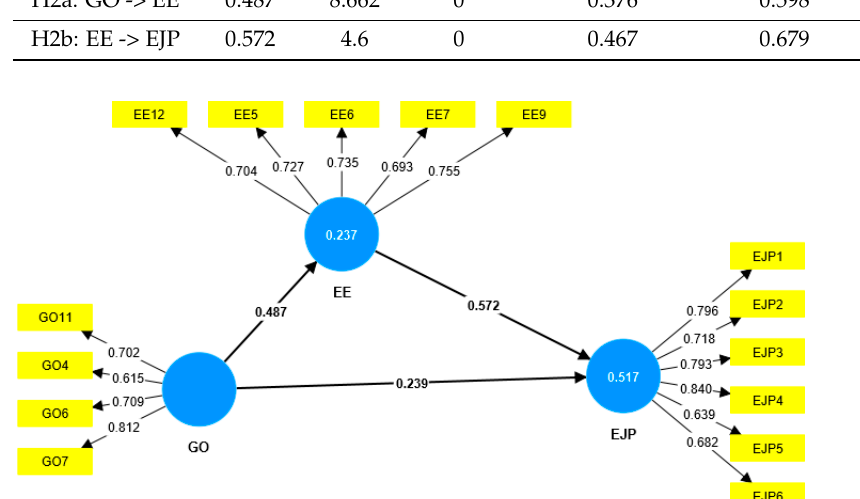
Figure 2. Structural Model .